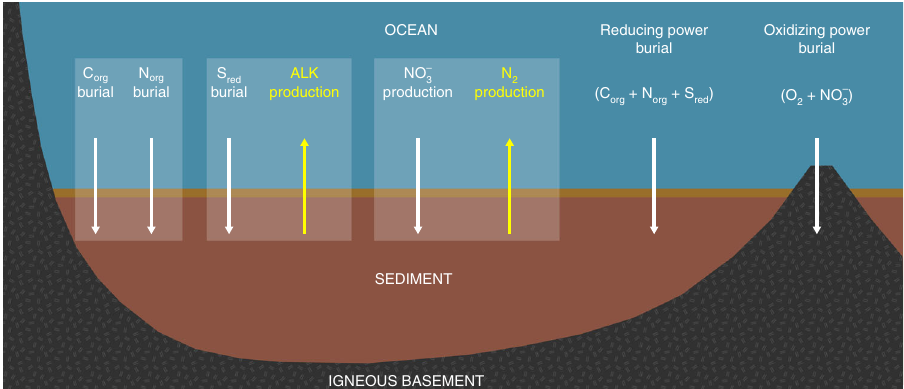
Fig. 4 Major net chemical fl uxes due to microbial activities in subsea fl oor environments. Subsea fl oor microbial activities control burial fl uxes of organic carbon (C org ), organic nitrogen (N org ), and reduced sulfur (S red ) (typically buried as iron sul fi de), as well as production fl uxes of alkalinity (ALK) and N 2 . In doing so, they control the rate at which reducing power is buried. Microbes in igneous basement contribute to burial of oxidizing power (via reduction of O 2 and NO 3